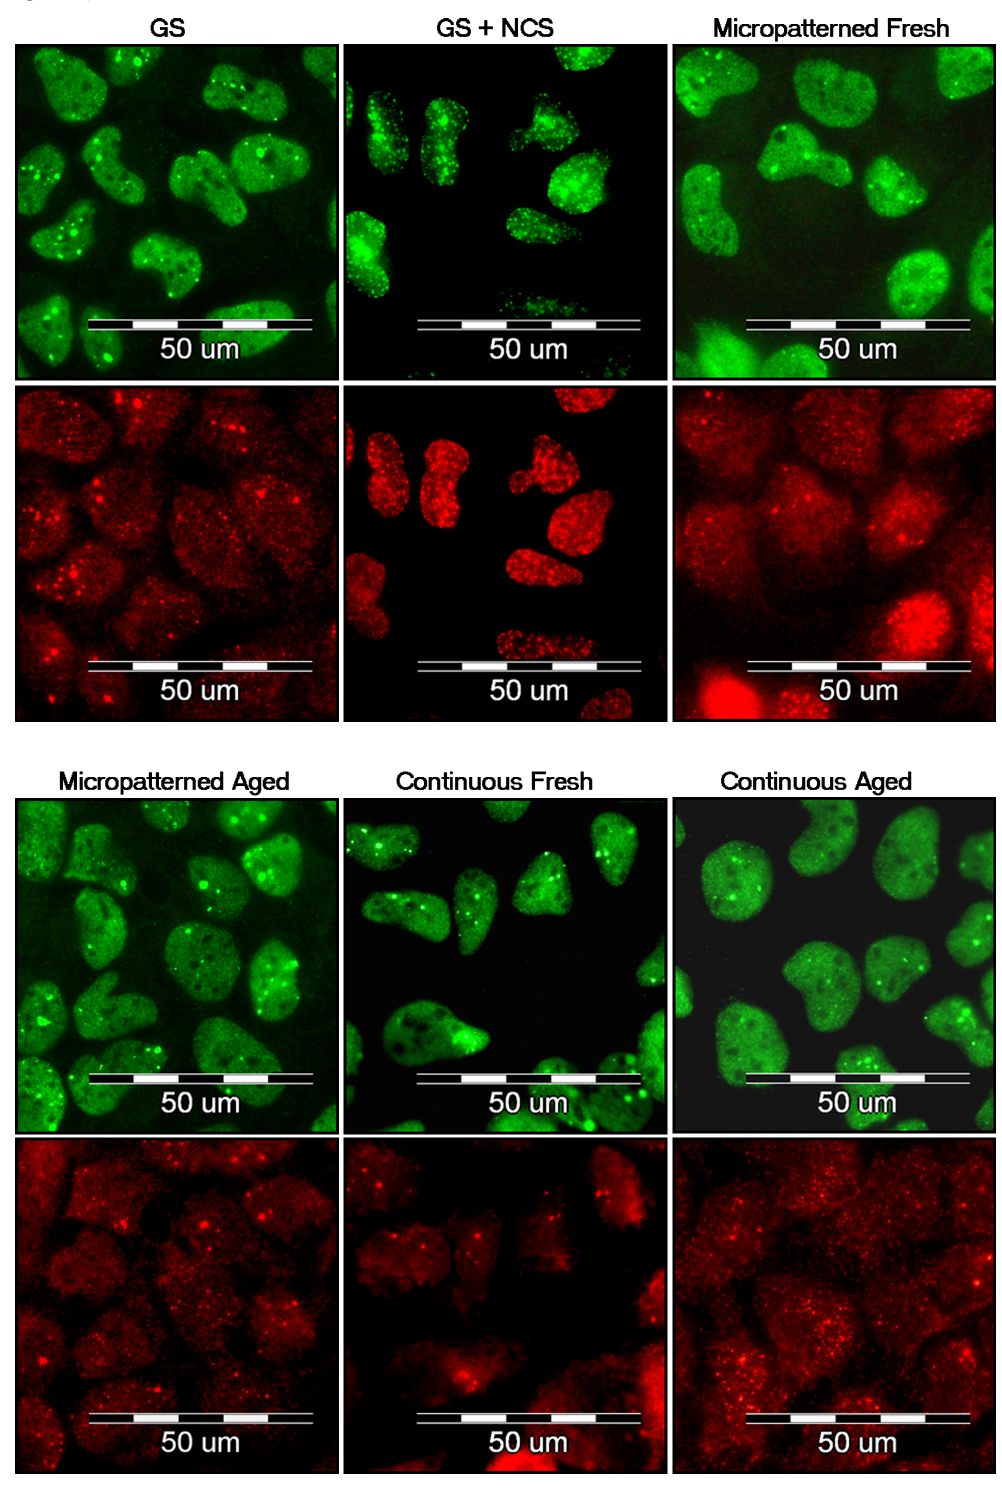
Figure 13. Immunofluorescence staining of markers of DNA damage response: 53BP1 (green) and gamma-H2AX (red) in human osteoblast-like U-2 OS cells on micropatterned or continuous fresh and aged fullerene films after seven days of cultivation. GS, microscopic glass coverslips, reference material; GS + NCS, positive control to DNA damage response, induced by 1 h incubation of U-2 OS cells in neocarzinostatin (NCS; 700